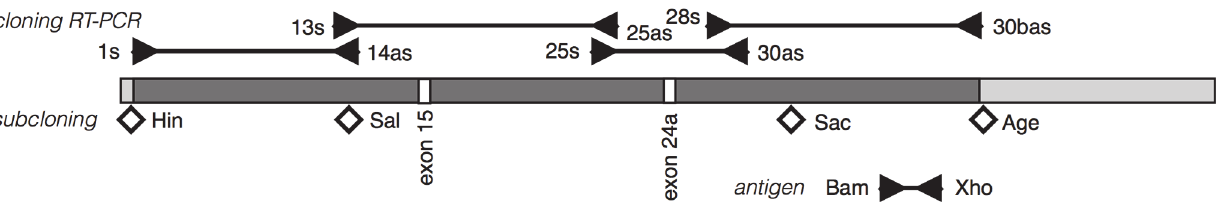
Fig 1. Isolation of a full-length TRPM3 cDNA from mouse retina by RT-PCR. Four segments of TRPM3 were amplified from retina cDNA. The primer ’ s exon and orientation (sense vs antisense) are indicated. The 5 ’ and 3 ’ untranslated regions are shown in light grey, the coding region in dark, and splice variation (see text) in white. Restriction enzyme sites used for sequential cloning of overlap extension products are indicated by diamonds. The location of the Bam HI- Xho I cDNA fragment encoding the antigen used to raise an anti-TRPM3 antiserum is